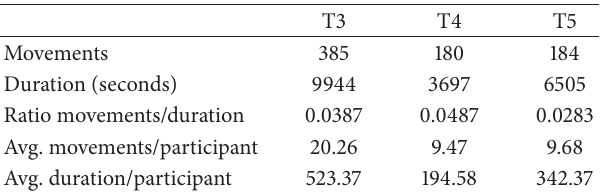
Table 1: Movements detected per task and task duration, as well as average per